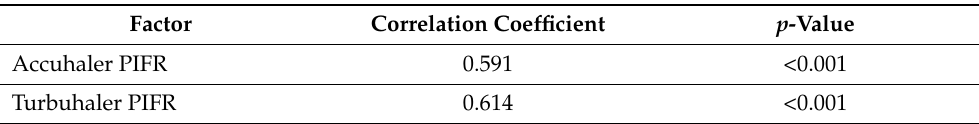
Table 3. Correlation between handgrip strength with peak inspiratory flow rate for Accuhaler and